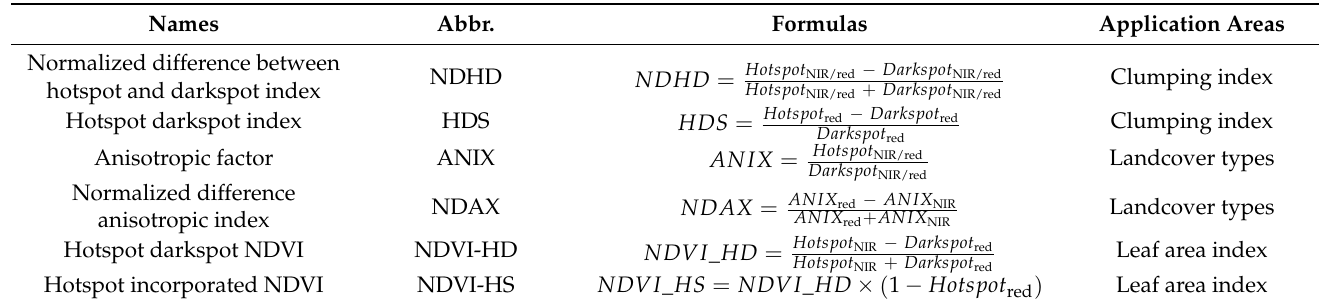
Table 1. Formulating MODIS BRDF shape indicators based on the multi-angle reflectances observed from the hotspot, nadir, and darkspot directions of the red and NIR bands.